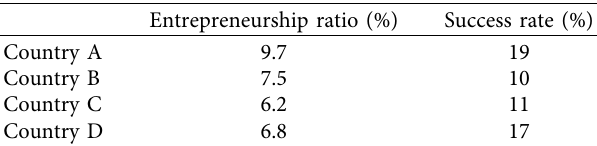
Figure 7: College students’ entrepreneurship policy guarantee system. Table 3: Entrepreneurship in universities in countries A–D.